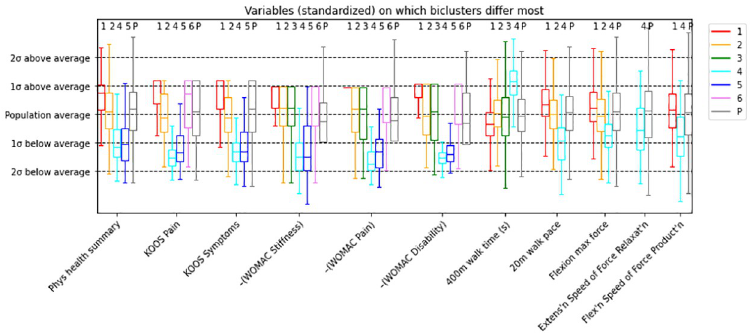
Fig 3. Boxplot comparing key continuous variables across the 6 biclusters and the overall population of knees (P). The y-axis represents standardized values and standard deviations, and the x-axis indicates the features. Boxplots are colored by bicluster numbers, with P = population in gray indicating the overall cohort mean and distribution.